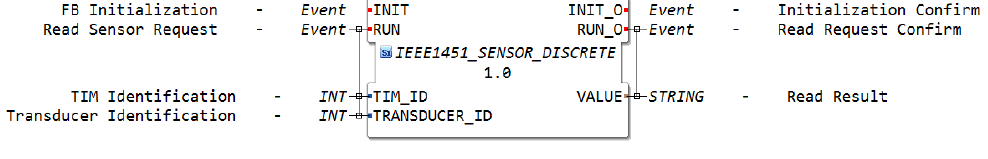
Figure 2. Smart Function Block—IEEE 1451 Sensor (Discrete).